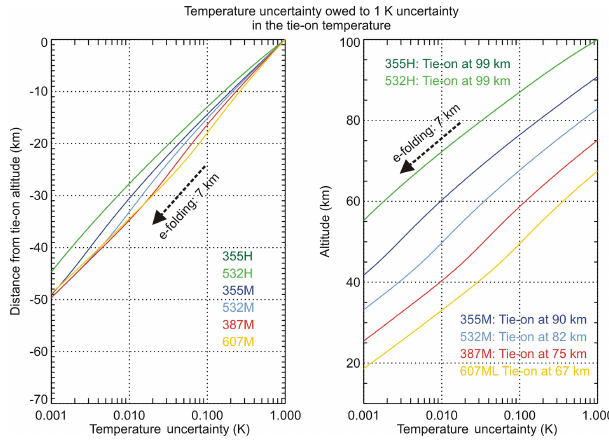
Figure 7. Temperature uncertainty owing to the a priori use of an- cillary ozone number density (left) and NO 2 number density (right) for the absorption correction. The results are shown per 1% un- certainty (solid curves), and for 1ppmv ozone uncertainty (dashed curves, left) and 1ppbv NO 2 uncertainty (dashed curves, right).